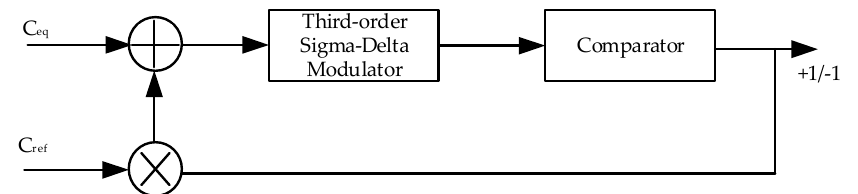
Figure 1. Charge balanced operation of the capacitance-to-digital converter (CDC).